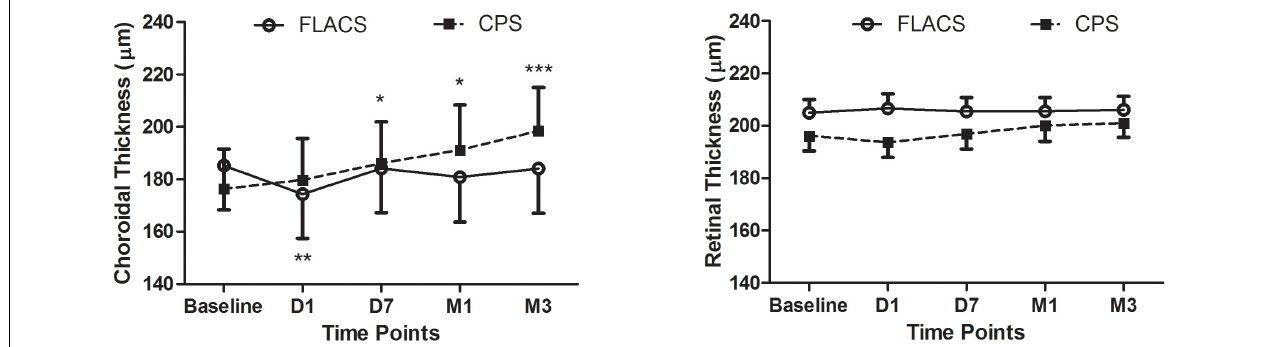
FIGURE 1 | Time courses of the subfoveal choroidal (left) and retinal (right) thicknesses before and after cataract surgery. Repeated-measures ANOVA of the choroidal changes indicated significant changes in both groups (both P < 0.01). The SFCT in the CPS group exhibited a trend toward an increase over time (P D 1 = 0.28, P D 7 = 0.016, P M 1 = 0.020, and P M 3 < 0.001). In contrast, the SFCT of the FLACS group did not change with the exception of a slight decrease at postoperative D1 (P D 1 = 0.006, P D 7 = 0.66, P M 1 = 0.22, and P M 3 = 0.53). In contrast, repeated-measures ANOVAs of the retinal changes were not significant in either group (P FLACS = 0.47 and P CPS = 0.39). * p -value < 0.05, ** p -value < 0.01, *** p -value < 0.001.